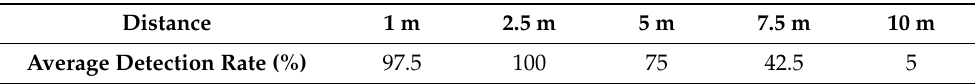
Table 6. Average success rate per distance, considering every test scenario up to 10 m. Distance